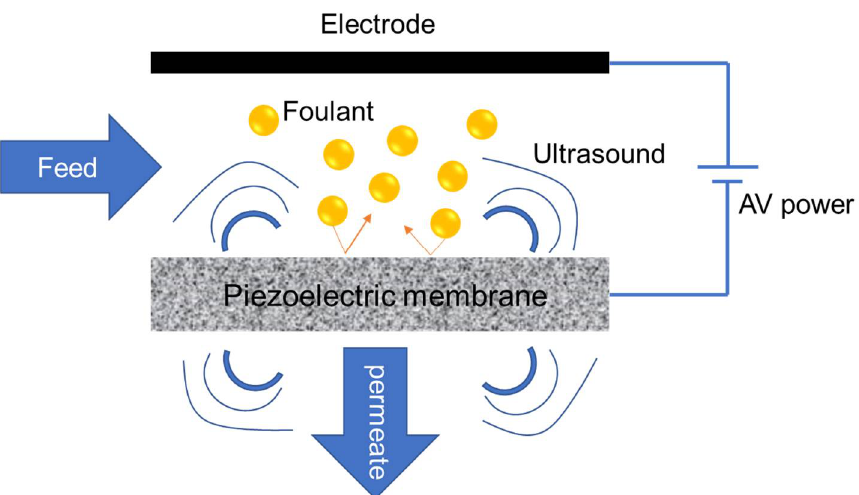
Figure 3. Schematic of the self-cleaning mechanism of the piezoelectric membrane. The membrane can create in-situ ultrasound to remove the pollutants deposited on the